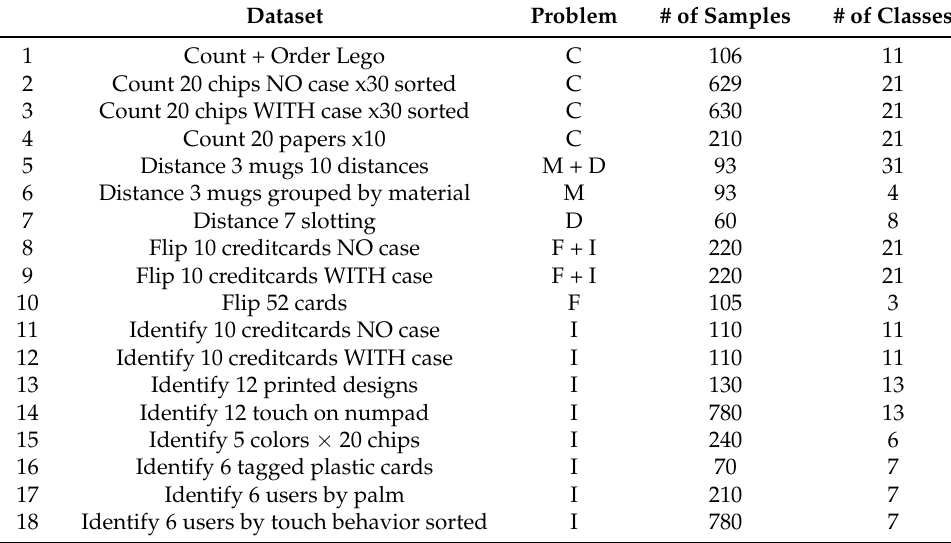
Table 1. Columns show radar datasets used, including the problem type (C, Counting; M, Material Identification; D, Distance estimation; O, Order identification; F, Flipping identification (Up/Down)); I, Object identification; R, Movement, rotation; P, Movement, position), the total number of samples, and the number of classes for each dataset. Dataset Problem # of Samples # of